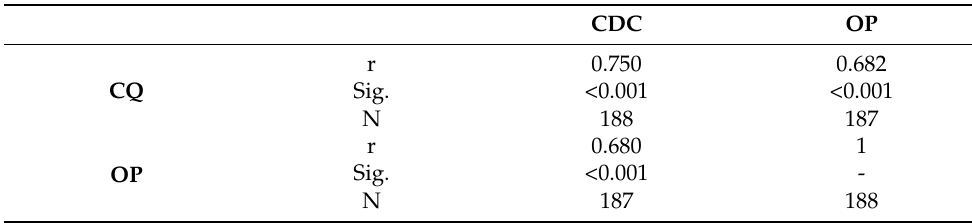
Table 4. Correlation analysis between analyzed variables.